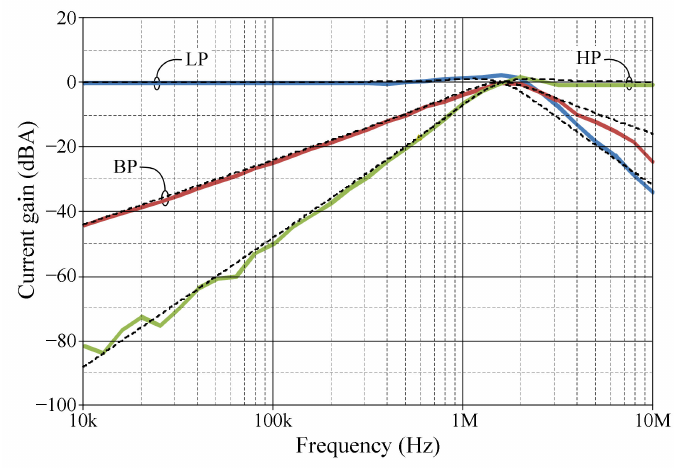
Figure 21. Ideal (dashed line) and measured (solid line) frequency responses for CM.